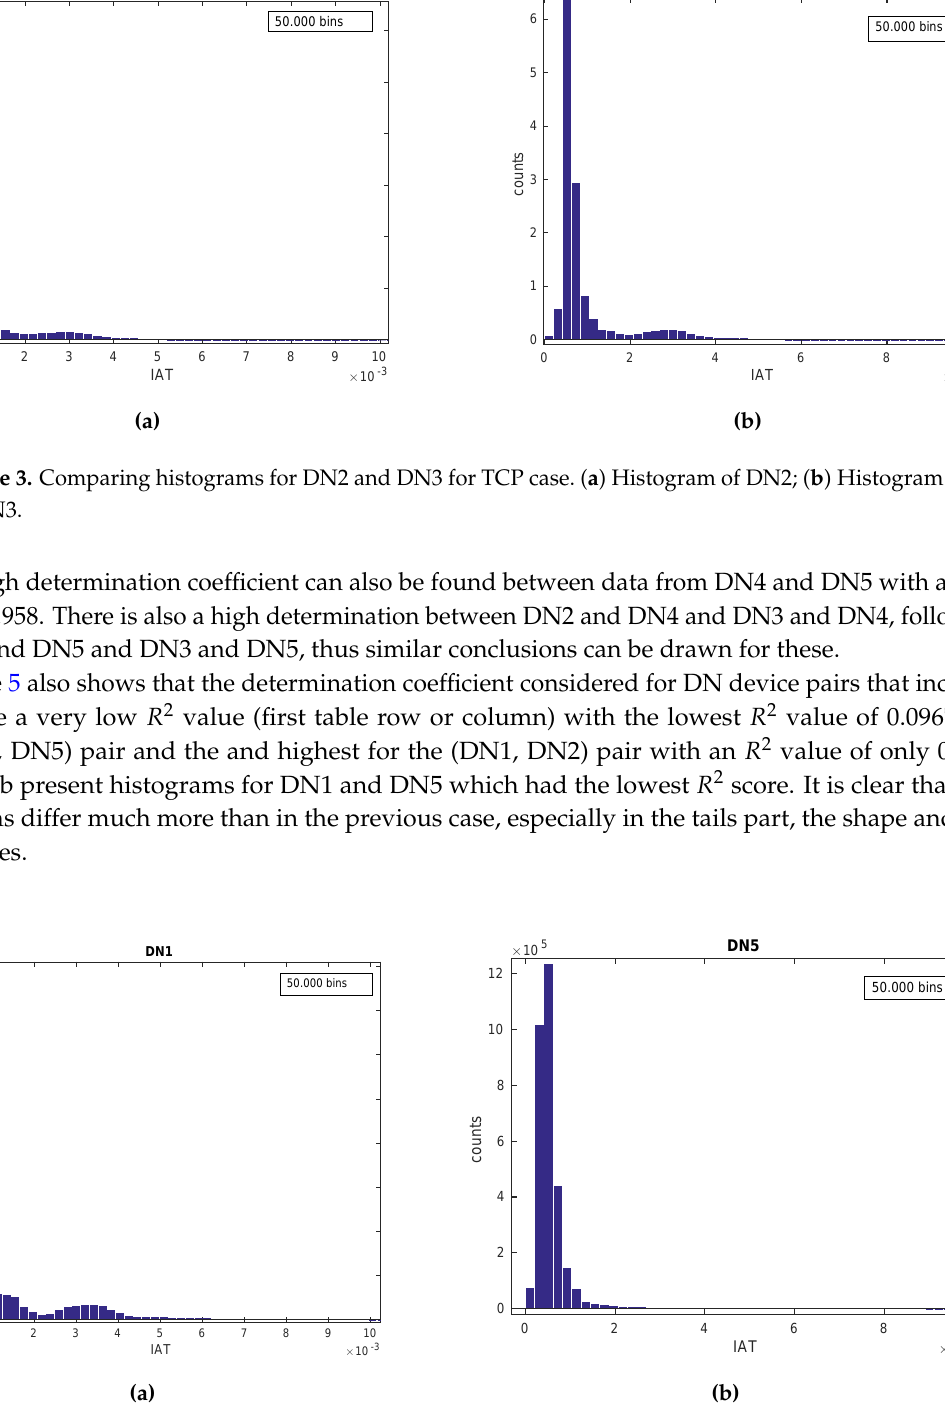
Figure 4. Comparing histograms for DN1 and DN5 for TCP case. ( a ) Histogram of DN1; ( b ) Histogram of